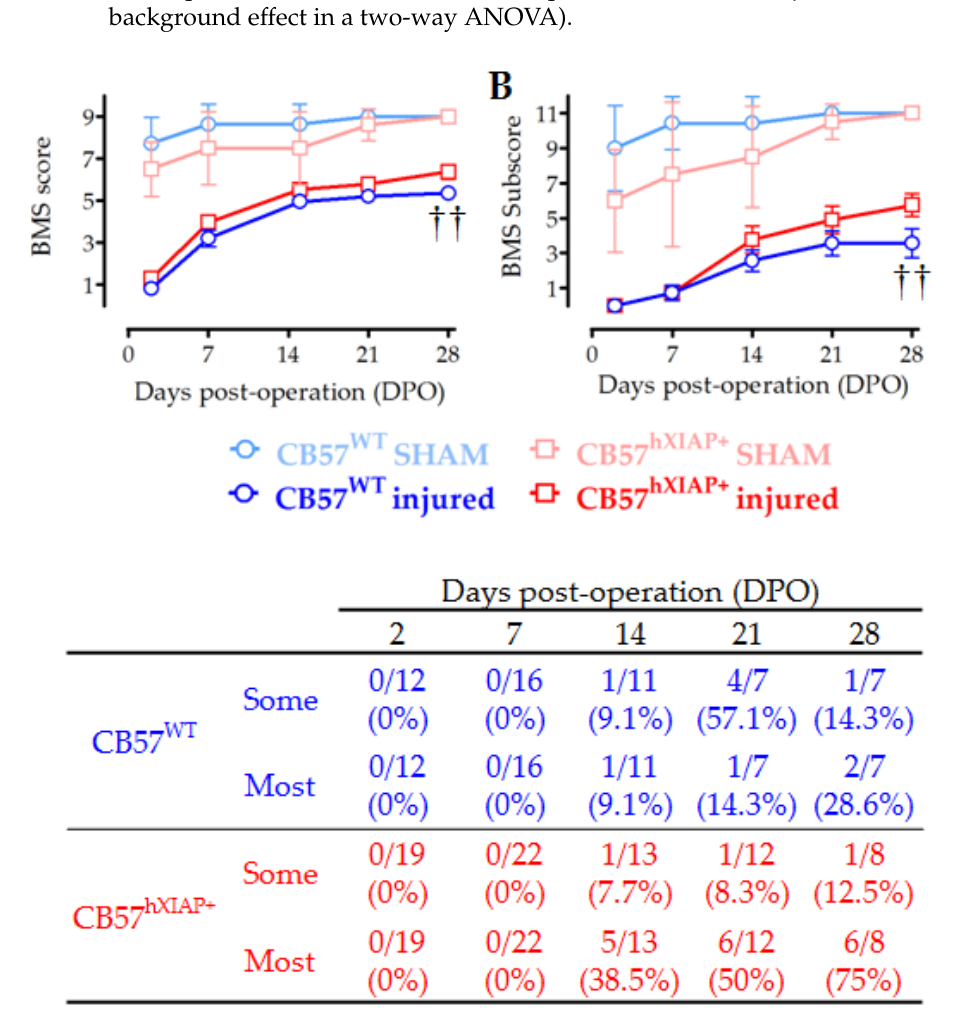
Figure 4. Improvement in locomotor capacities by overexpression of hXIAP after SCI. We used BMS to determine the locomotor skills of spinal cord-injured WT (CB57 WT , dark blue line and symbols are for injured mice and light blue line and symbols are for sham animals) and hXIAP overexpressing mice (CB57 hXIAP+ , red line and symbols are for injured mice and light red and symbols are for sham animals). ( A ) BMS score reveals that overexpression of hXIAP reduces the locomotor impairment derived from SCI (†† = p -value < 0.01 for the effect of genetic background in a two-way ANOVA). ( B ) Improvements become more evident when locomotion parameters are coded according to the BMS subscore (†† = p -value < 0.01 for the effect of genetic background in a two-way ANOVA). ( C ) The specific analysis of interlimb coordination shows that overexpression of hXIAP tends to increase the percentage of animals with coordinative capacities at 21 and 28 dpo (symbols represent mean ±